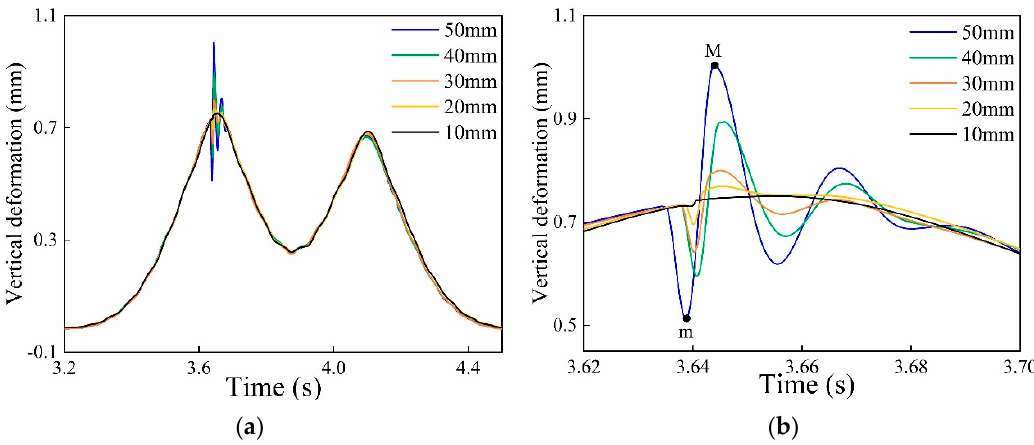
Figure 8. The impact response curves of the wheel flats at 20 km/h: ( a ) The impact response curves of the different flat lengths; ( b ) The flat signal waveforms.